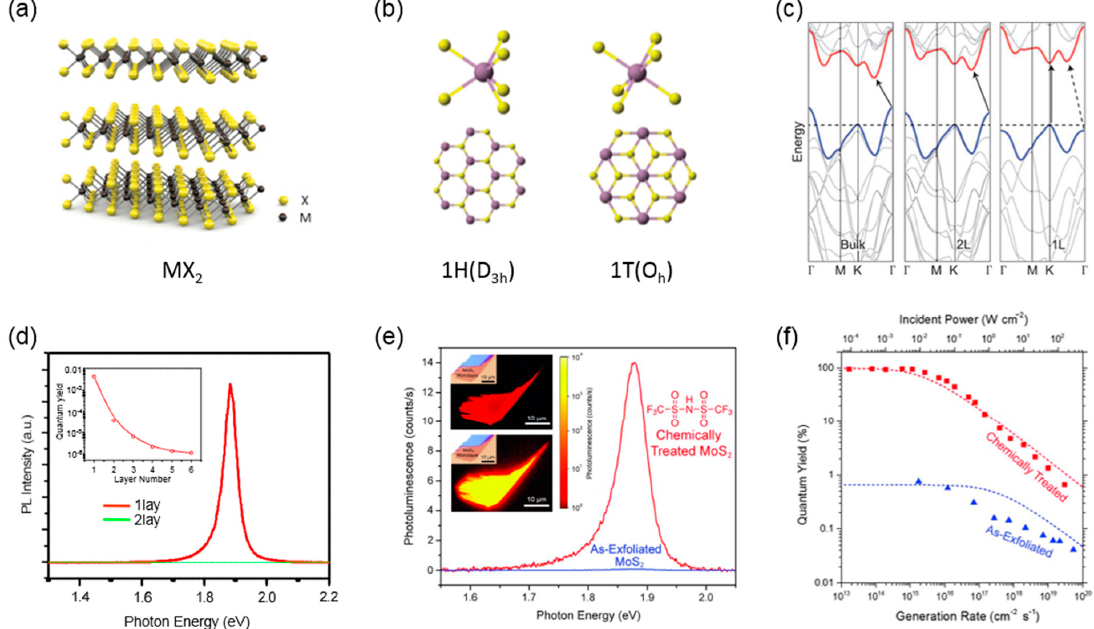
Figure 2. ( a ) Crystal structure of a transition metal dichalcogenide (TMDC), MX 2 [29]; ( b ) atomic arrangement of two structural polymorphs of MoS 2 identified as one hexagonal (1H), one tetragonal (1T) [54]; ( c ) band structures of bulk, bilayer (2L) and monolayer (1L) MoS 2 [56]; ( d ) Photoluminescence (PL) spectra for 1L and 2L MoS 2 , Inset: quantum yield as a function of the number of layers [23]; ( e ) PL spectra for as ‐ exfoliated and TFSI ‐ treated MoS 2 monolayers, Inset: PL intensity maps for each samples; and ( f ) power dependence of the quantum yield for as ‐ exfoliated and